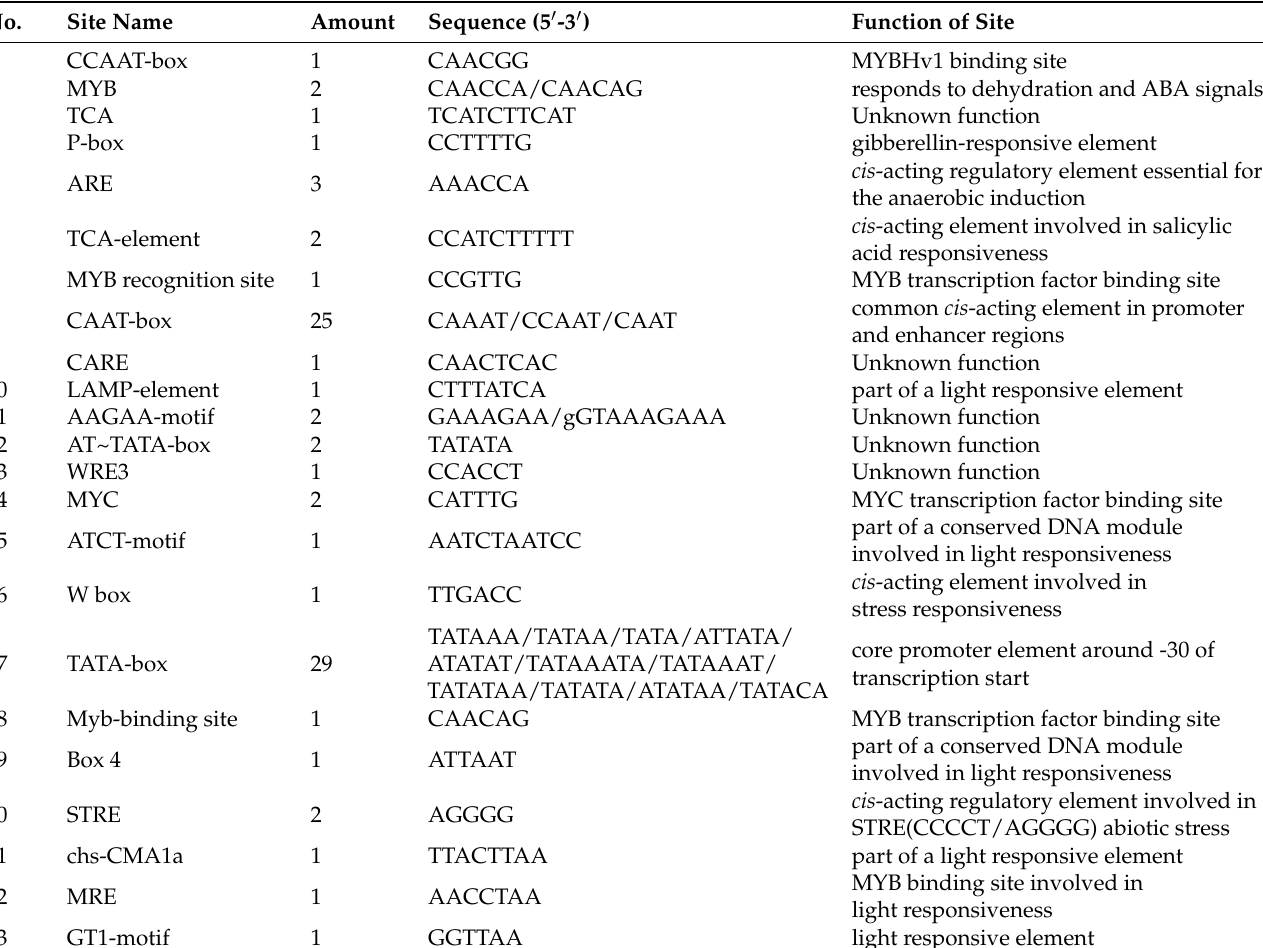
Table 2. Cis -acting regulatory element analysis of the LhSorPR4-2 promoter